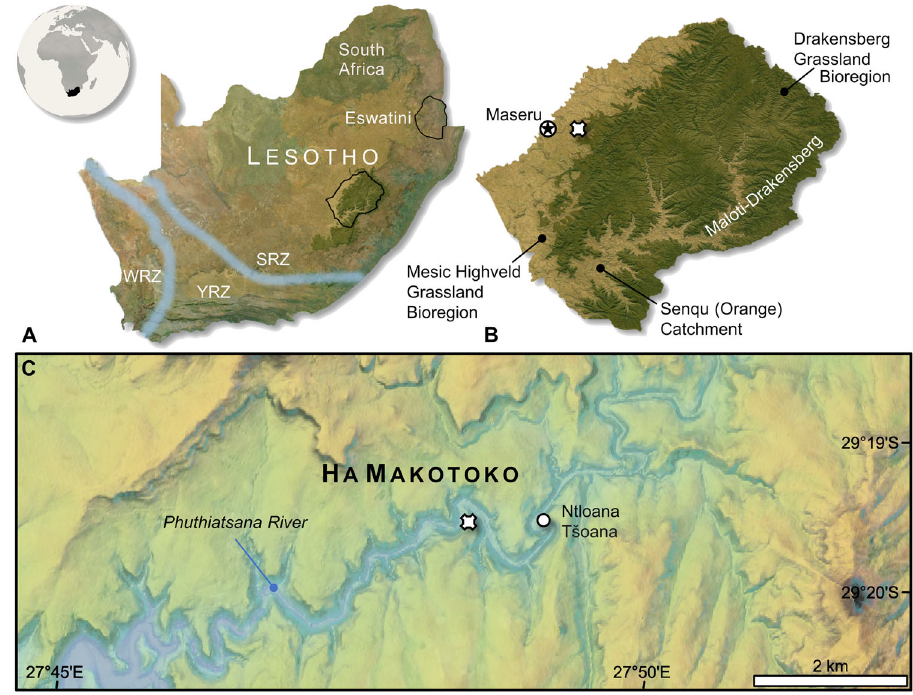
Fig. 1 Location of the Ha Makotoko archaeological site in Lesotho, southern Africa. A Location of Lesotho and the boundaries of the different main rainfall zones: SRZ Summer Rainfall Zone; YRZ Year-round Rainfall Zone; WRZ Winter Rainfall Zone. B The location of Ha Makotoko in Lesotho in the Mesic Highveld Grassland bioregion (tan area). The Mesic Highveld Grassland is found mainly in western/northwestern Lesotho and in major river valleys while the Drakensberg Grassland (green area) is the dominant bioregion of central and eastern Lesotho 49 . C Location of Ha Makotoko and neighbouring Ntloana T š oana rockshelter within the Phuthiatsana Gorge. Maps created using ArcGIS Pro desktop GIS software developed by Esri and bioregion information from ref. 49